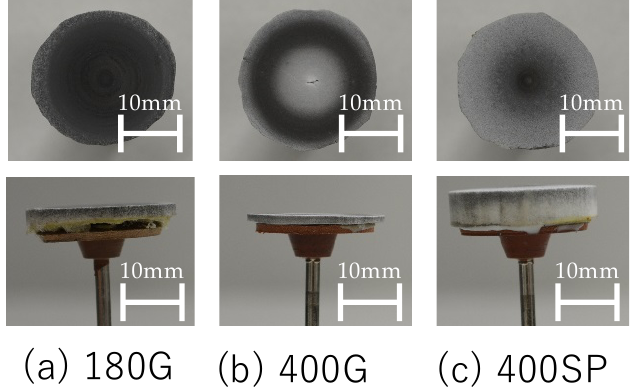
Figure 6. Conditions of the 180G, 400G, and 400SP wheels after